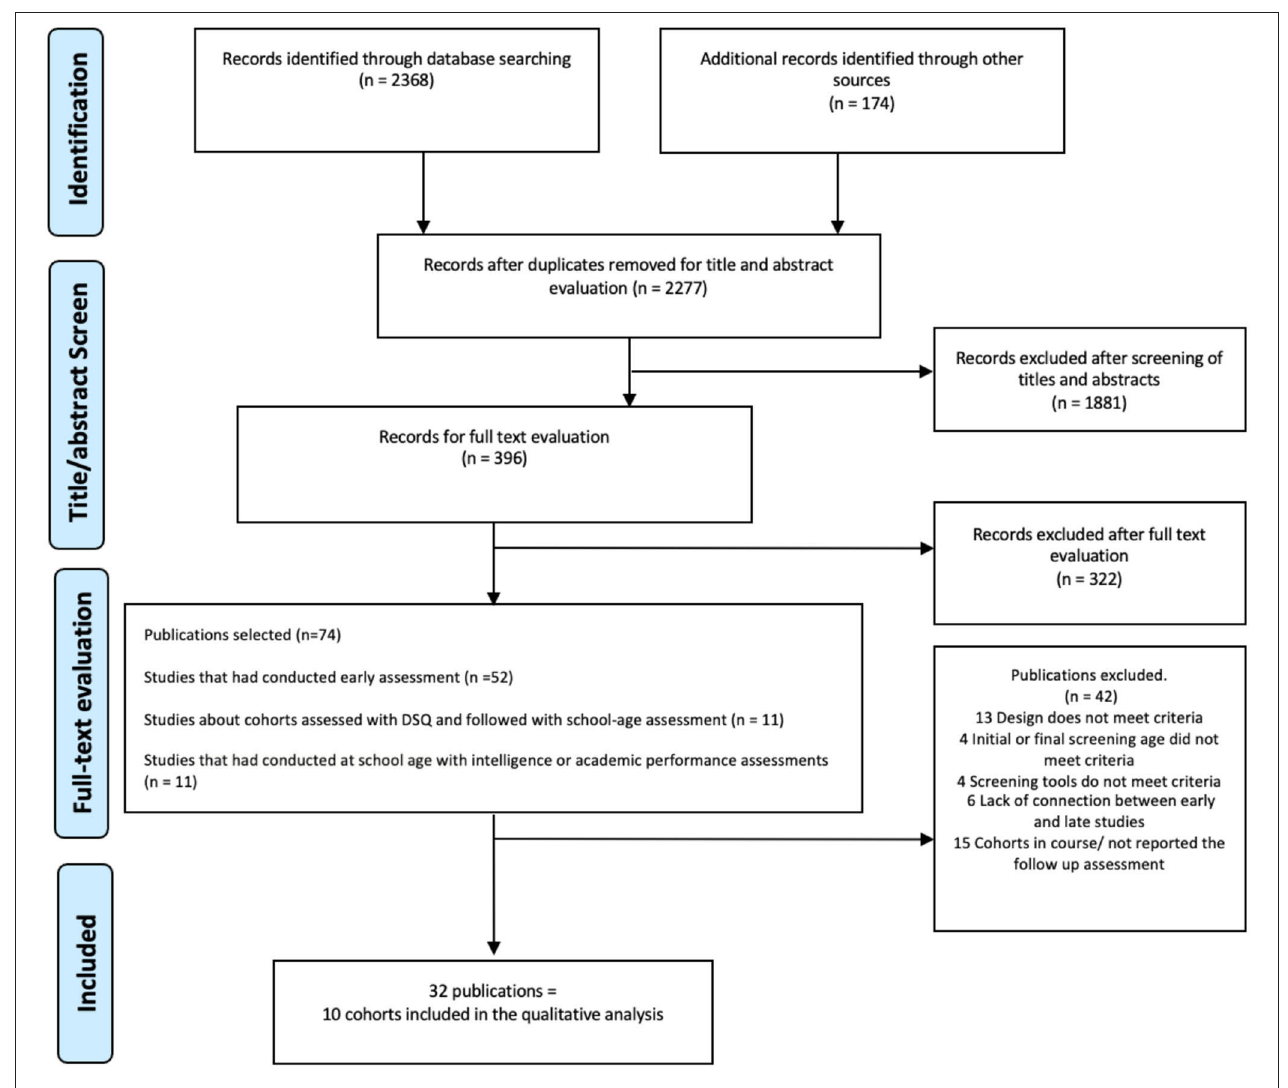
FIGURE 1 | PRISMA flow